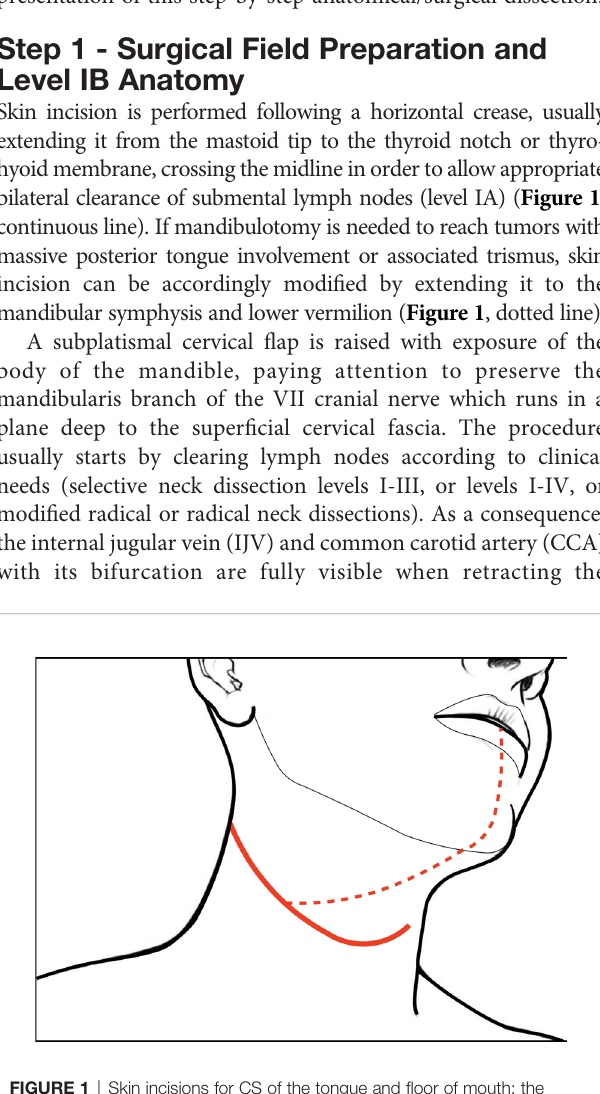
FIGURE 1 | Skin incisions for CS of the tongue and fl oor of mouth: the continuous line represents that usually followed in case of pull-through approach and unilateral neck dissection (while tracheostomy is performed via a separated caudal stab wound); dotted line indicates the incision for the transmandibular